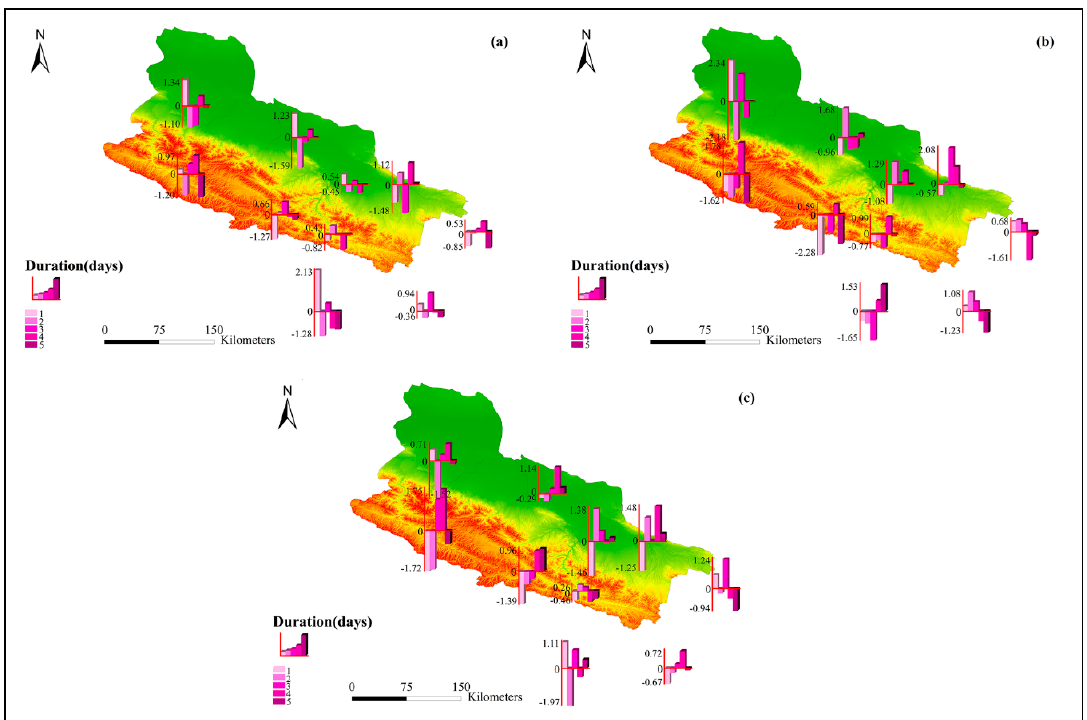
Figure 5. Spatial distribution of normalized fraction of Mann–Kendall Z values for different wet periods (WPs) before ( a ) and after ( b ) abrupt changes and over the total period ( c ) over the upper (UHRB) and the middle (MHRB) reaches of the Heihe River Basin.